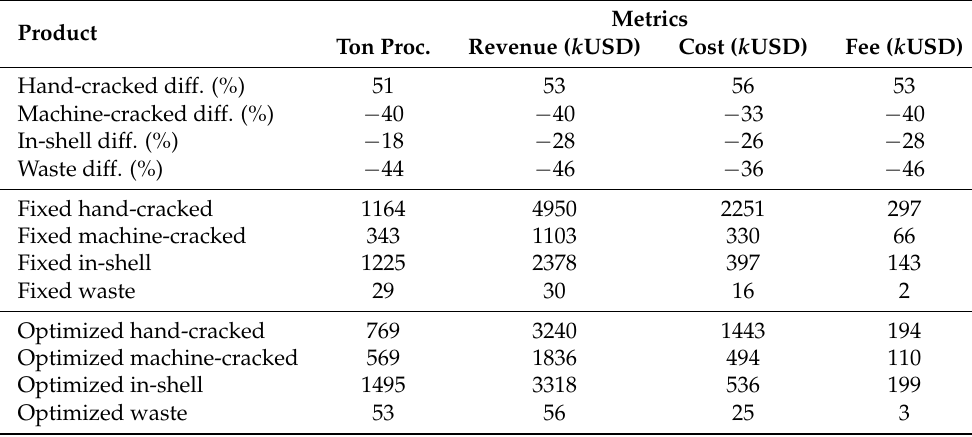
Table 5. DSS versus fixed solution metrics benchmark.